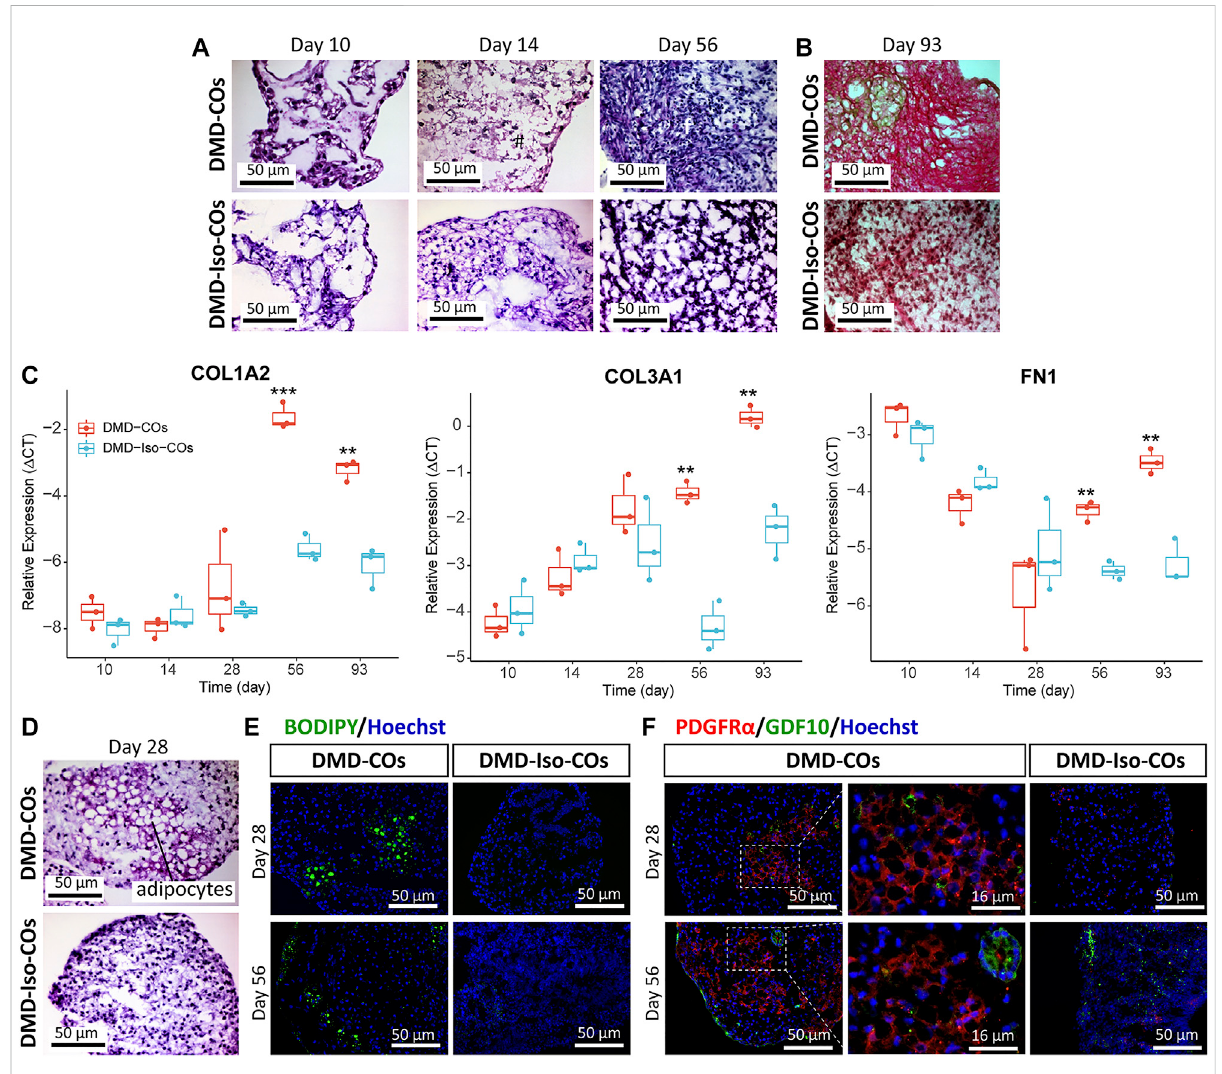
FIGURE 5 Assessment of fi brosis and adipogenesis in DMD-COs and DMD-Iso-COs over 93 days of dynamic culture. (A) H&E staining showing deterioration of cardiomyocyte tissue on day 14 and fi brosis on day 56 in DMD-COs. (Magni fi cation: ×40). (B) Picro-Sirius red staining showing abundant collagen deposition in DMD-COs on day 93. (Magni fi cation:×40). (C) RT-qPCR analysis of representative fi brosis gene markers showing a signi fi cantupregulationof COL1A2 , COL3A1 and FN1 expressioninDMD-COsonday56and93ascomparedtoDMD-Iso-COs.Datashownare mean ± s.d. ( n = 3, each pooled from ~10 organoids). Statistical analyses were performed by two-way ANOVA with Tukey ’ s multiple comparisons: ** p < 0.01,*** p < 0.001. (D – F) AdipogenesisinDMD-COsasindicatedbytheformationofadipocyteswithcytoplasmicvacuoles(H&Estaining),lipid droplet deposition (BODIPY staining), and PDGFR α positivity on day 28 and 56. The adipogenesis inhibitor GDF10 was also detected near the PDGFR α + cells in DMD-COs. Nuclei were counterstained with Hoechst. (Magni fi cation: ×20 and ×40). Data are representative of three independent experiments ( n =